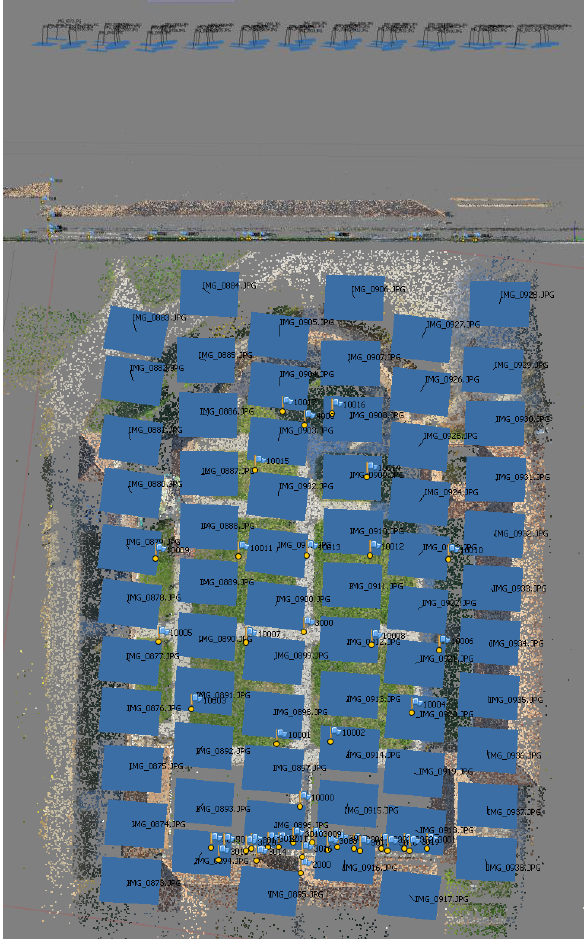
Figure 2. Flight structure. 66 images taken at 55m height.